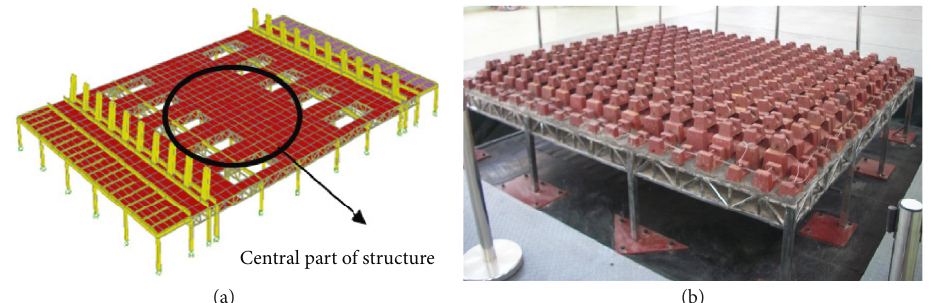
Figure 7: Shake table test with large-span floor specimen. (a) Numerical model; (b) test specimen.